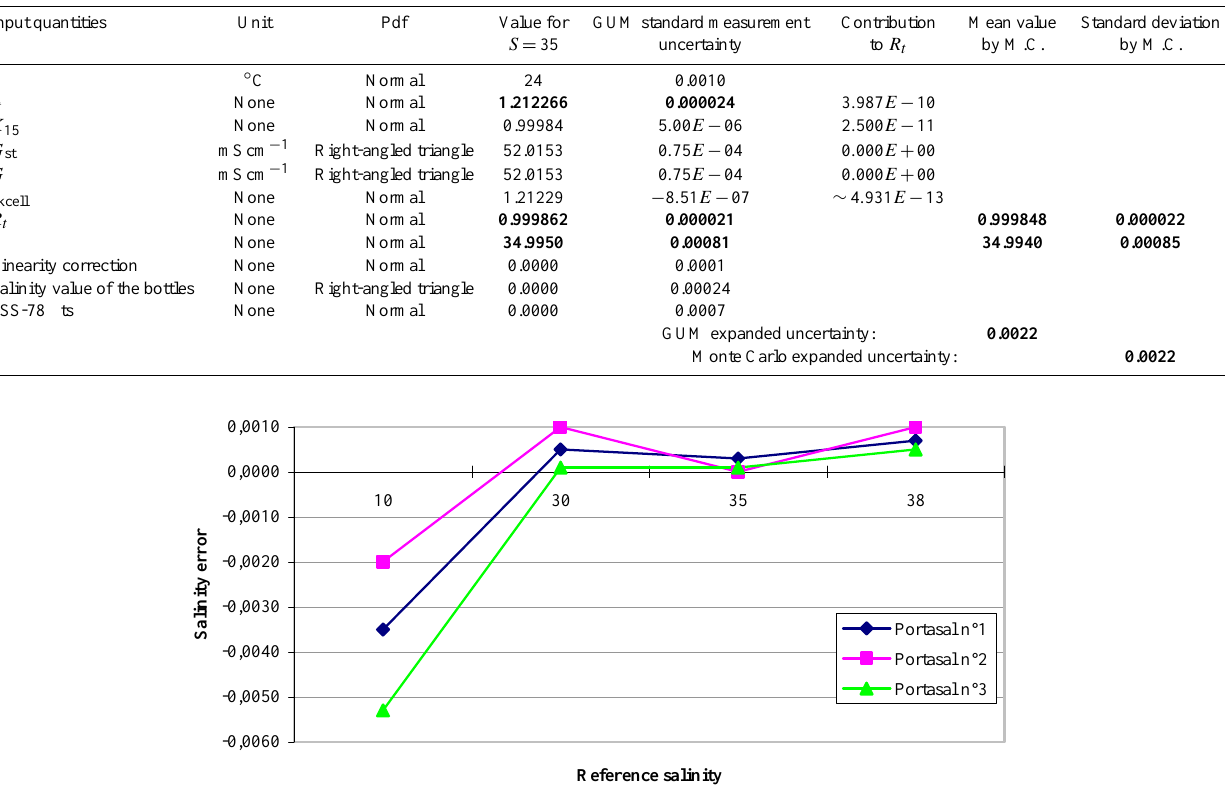
Figure n° 1: examples of linearity errors measured on three Portasal salinometers after Fig. 1. Examples of linearity errors measured on three Portasal salinometers after calibration with standard seawater bottles. calibration with standard seawater bottles. made by OSIL on Portasal salinometers (see Fig. 1).